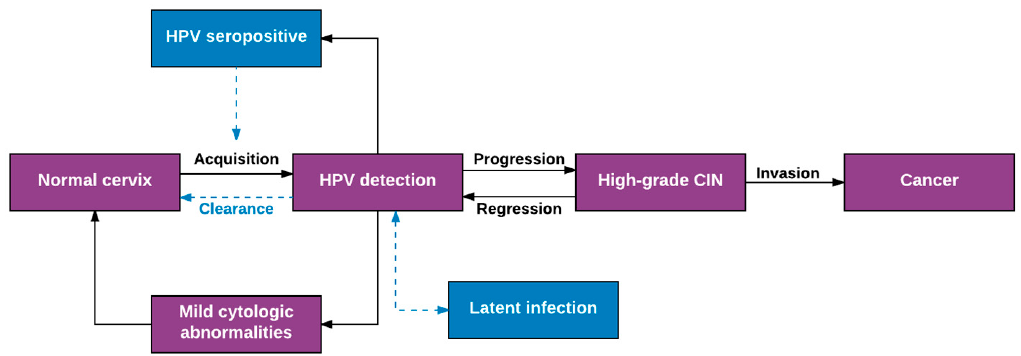
Figure 1. Schematic model of the population-level natural history of human papillomavirus infection and cervical cancer. Purple boxes indicate well-accepted natural history model parameters; blue boxes represent uncertainties.